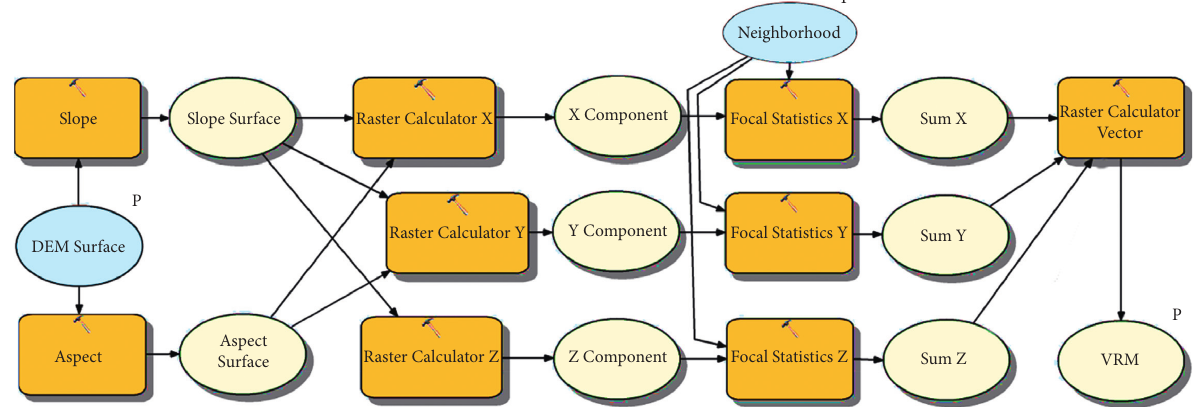
Figure 8: Model builder diagram to produce VRM map from DEM